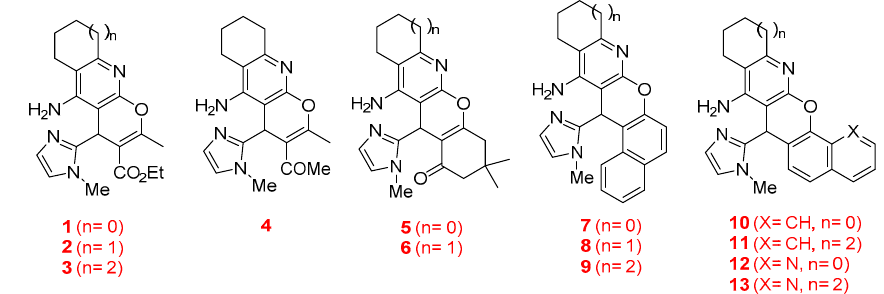
Figure 2. Structures of the imidazopyranotacrines 1 – 13 .